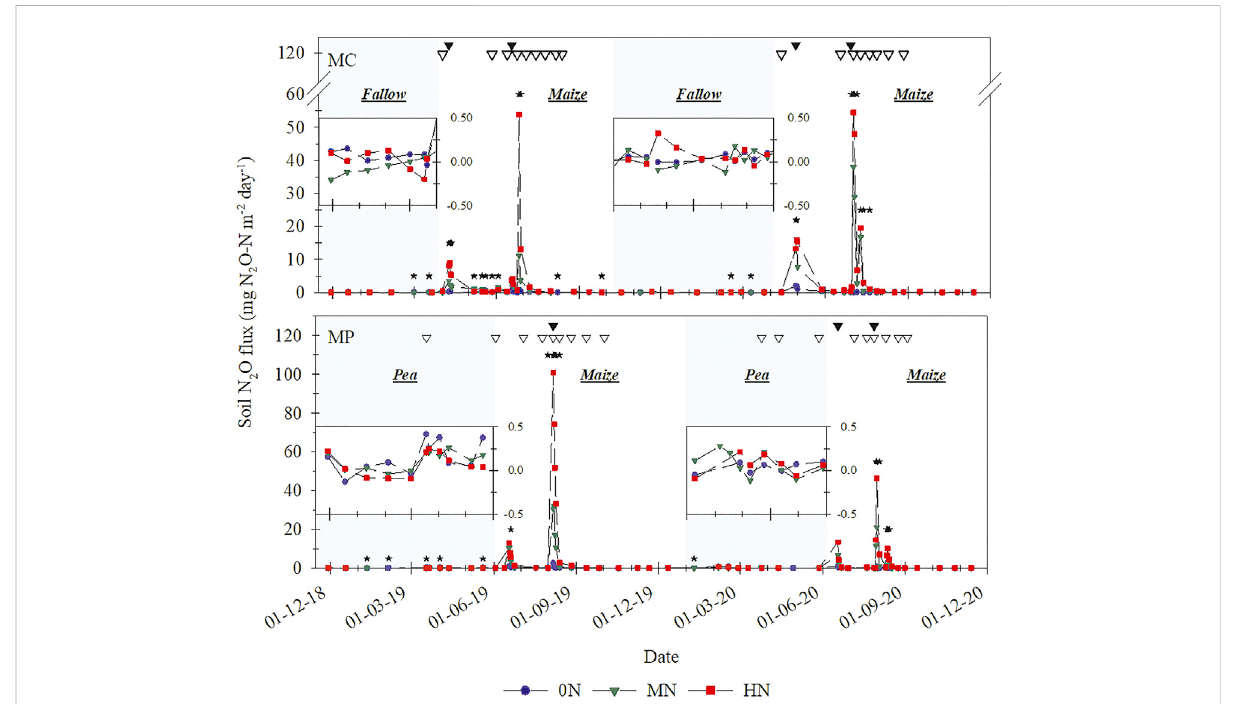
FIGURE 3 SoilN 2 O fl uxesinthemaizemonoculture(MC)systemandthepea-maize(MP)rotationasaffectedbysoilNrate:0N(unfertilized),MN(medium N rate) and HN (high N rate). * Indicates signi fi cant differences between treatments within a date at p < 0.05. Black triangles indicate fertilizer applications. White triangles indicate fl ood irrigation